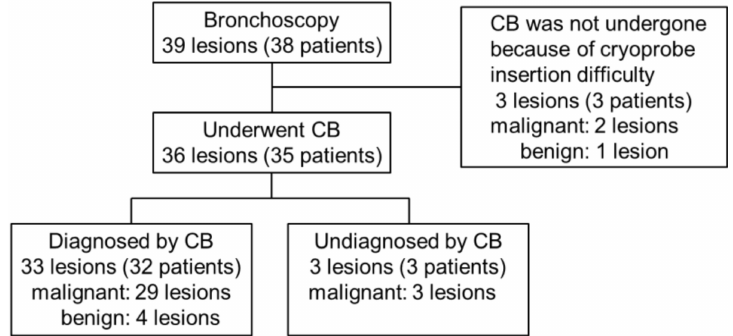
Figure 1. Flow diagram showing the results of cryobiopsy (CB) in 35 patients with peripheral pulmonary